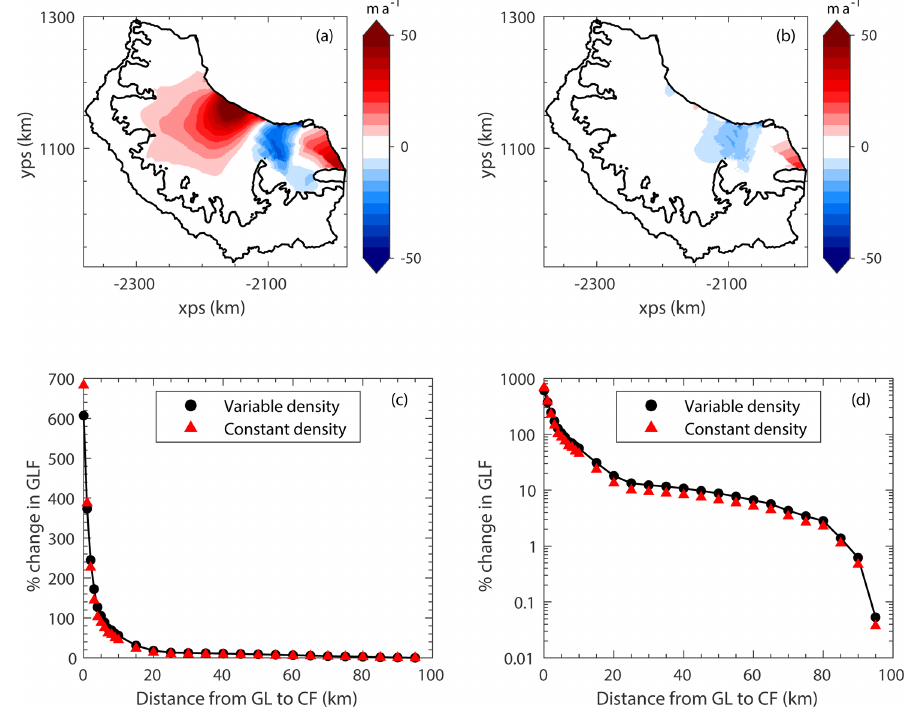
Figure D2. The results of calving experiments using a constant ice density of 917kgm − 3 . Panel (a) shows the modelled response to the calving of the A68 iceberg using the constant-density set-up, whilst (b) shows the difference between the constant-ice-density response and the variable-ice-density response to the A68 calving. Panels (c) and (d) show the instantaneous grounding line flux response to the idealised calving experiments for the variable-ice-density set-up (black; the same data as in Fig. 4a and b) and the constant-ice-density set-up (red).